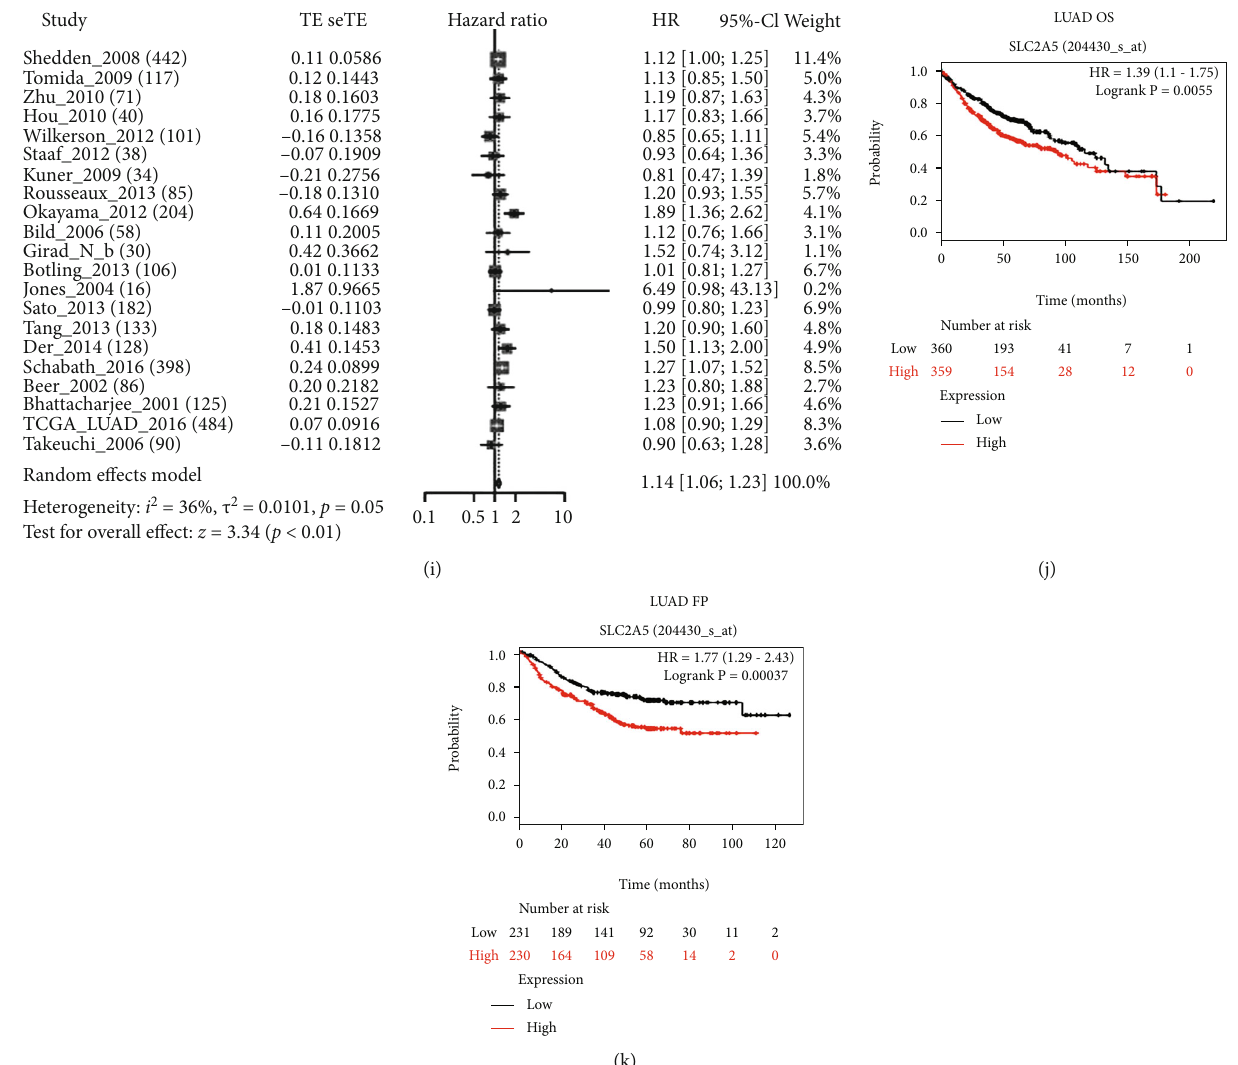
Figure 3: SLC2A5 is associated with survival outcome. (a – d) There was a signi fi cant correlation between prognosis in LUAD patients and expression of SLC2A5. (e – h) Several other types of cancer show a correlation between the patient ’ s prognostic period and the expression of SLC2A5. (i) Forest plot of survival analysis results associated with high SLC2A5 expression. (j, k) Survival analyses of SLC2A5 by the Kaplan-Meier plotter web tool. (j) Overall survival (OS) of LUAD ( P < 0 : 5 ) on SLC2A5 gene expression. (k) First progression (FP) of LUAD ( P < 0 : 5 ) on SLC2A5 gene expression. Survival di ff erences are compared between patients with high and low (grouped according to median) expression of SLC2A5. The numbers below the fi gures denote the number of patients at risk in each